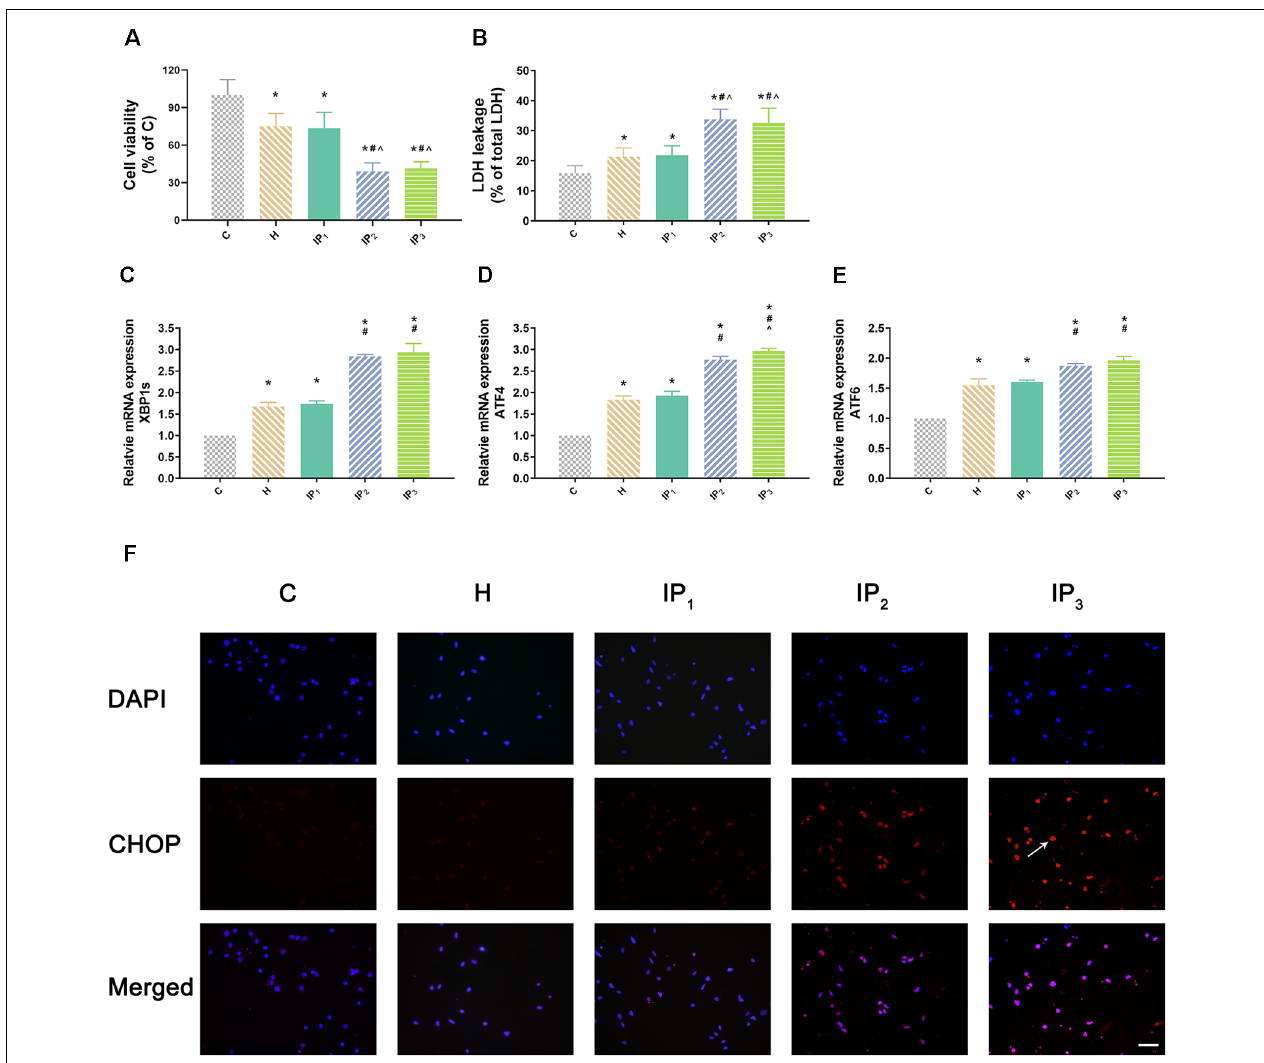
FIGURE 1 | One percent isoflurane and 1.2 µ g/ml of propofol caused the least damage to the hypoxic neurons. (A) Statistical graph of the neurons viability determined by the Cell Counting Kit-8 (CCK-8) assay. Data are expressed as the mean ± standard deviation (SD; n = 6/group). Note that hypoxia resulted in a significant decrease in cells viability. IP 2 and IP 3 aggravated this injury but IP 1 did not. (B) Statistical graph of the neurons cytotoxicity determined by the lactic acid dehydrogenase (LDH) assay. Data are expressed as the mean ± SD ( n = 6/group). Note that hypoxia resulted in a significant increase in cells cytotoxicity. IP 2 and IP 3 aggravated this injury but IP 1 did not. (C–E) mRNA level analysis of XBP1s, ATF4, and ATF6 in neurons. Data are expressed as the mean ± SD ( n = 6/group). Note that hypoxia resulted in a significant increase in transcription of XBP1s, ATF4, and ATF6. IP 2 and IP 3 aggravated this injury but IP 1 did not. (F) Immunofluorescent microscopy for CHOP. Nuclear was stained by DAPI; CHOP antibody was marked by rhodamine Red-X. Note that IP 2 and IP 3 caused an increase in expression of CHOP but IP 1 did not. * P < 0.05 compared with group C; # P < 0.05 compared with group H; ∧ P < 0.05 compared with group IP 1 . Scale bars = 200 µ m.